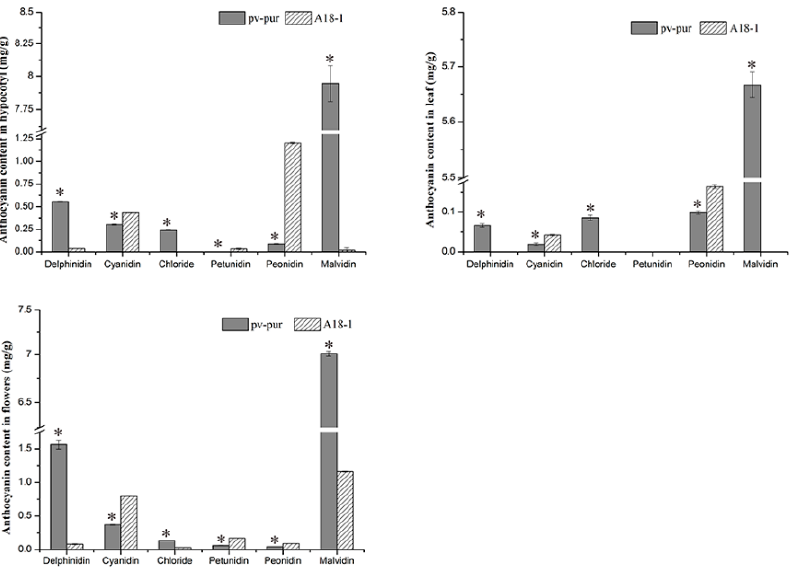
Figure 7. Concentration of six anthocyanins in different tissues of wild type ‘A18-1’ and mutant ‘ pv-pur ’. Note: * represents significant differences at p ≤ 0.05 based on ANOVA (Tukey test).